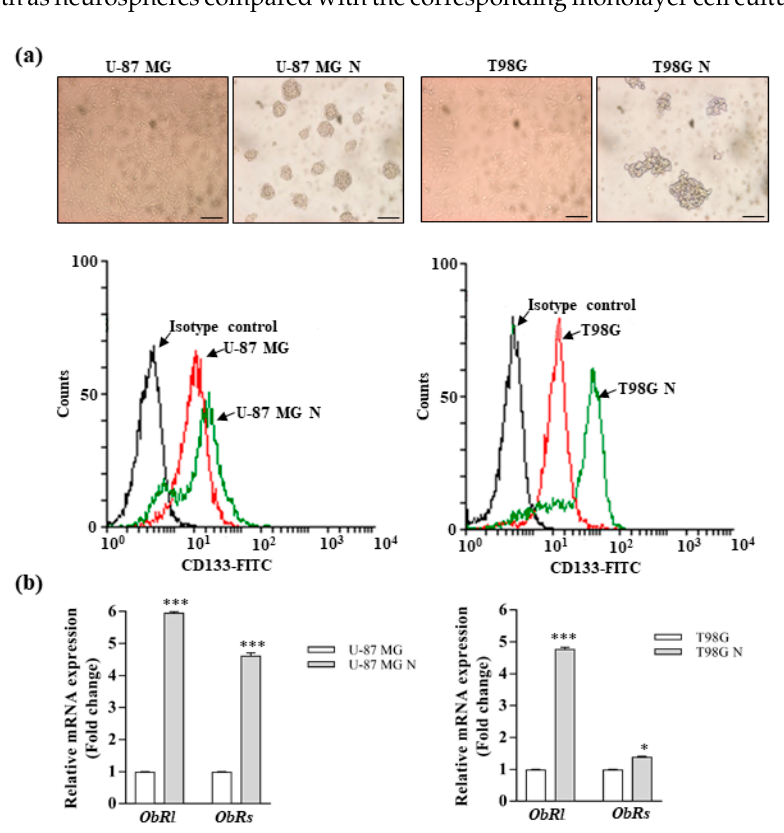
Figure 3. Characterization of glioblastoma stem-like cells. ( a ) Representative phase contrast images of neurospheres derived from U-87 MG and T98G cells (U-87 MG N and T98G N, respectively). Upper panel. Scale bars = 50 µ m. Original magnification, × 10. Lower panel. Flow cytometry analysis of the CD133-positive (CD133-FITC) subpopulation of cells growth as neurospheres. ( b ) Leptin receptor long ( ObRl ) and short ( ObRs ) isoform mRNA levels, evaluated by real-time RT-PCR, in U-87 MG, U-87 MG N, T98G, and T98G N cells. Data are expressed as means ± SD of three di ff erent experiments, each performed in triplicate. * p < 0.05 and *** p < 0.001.